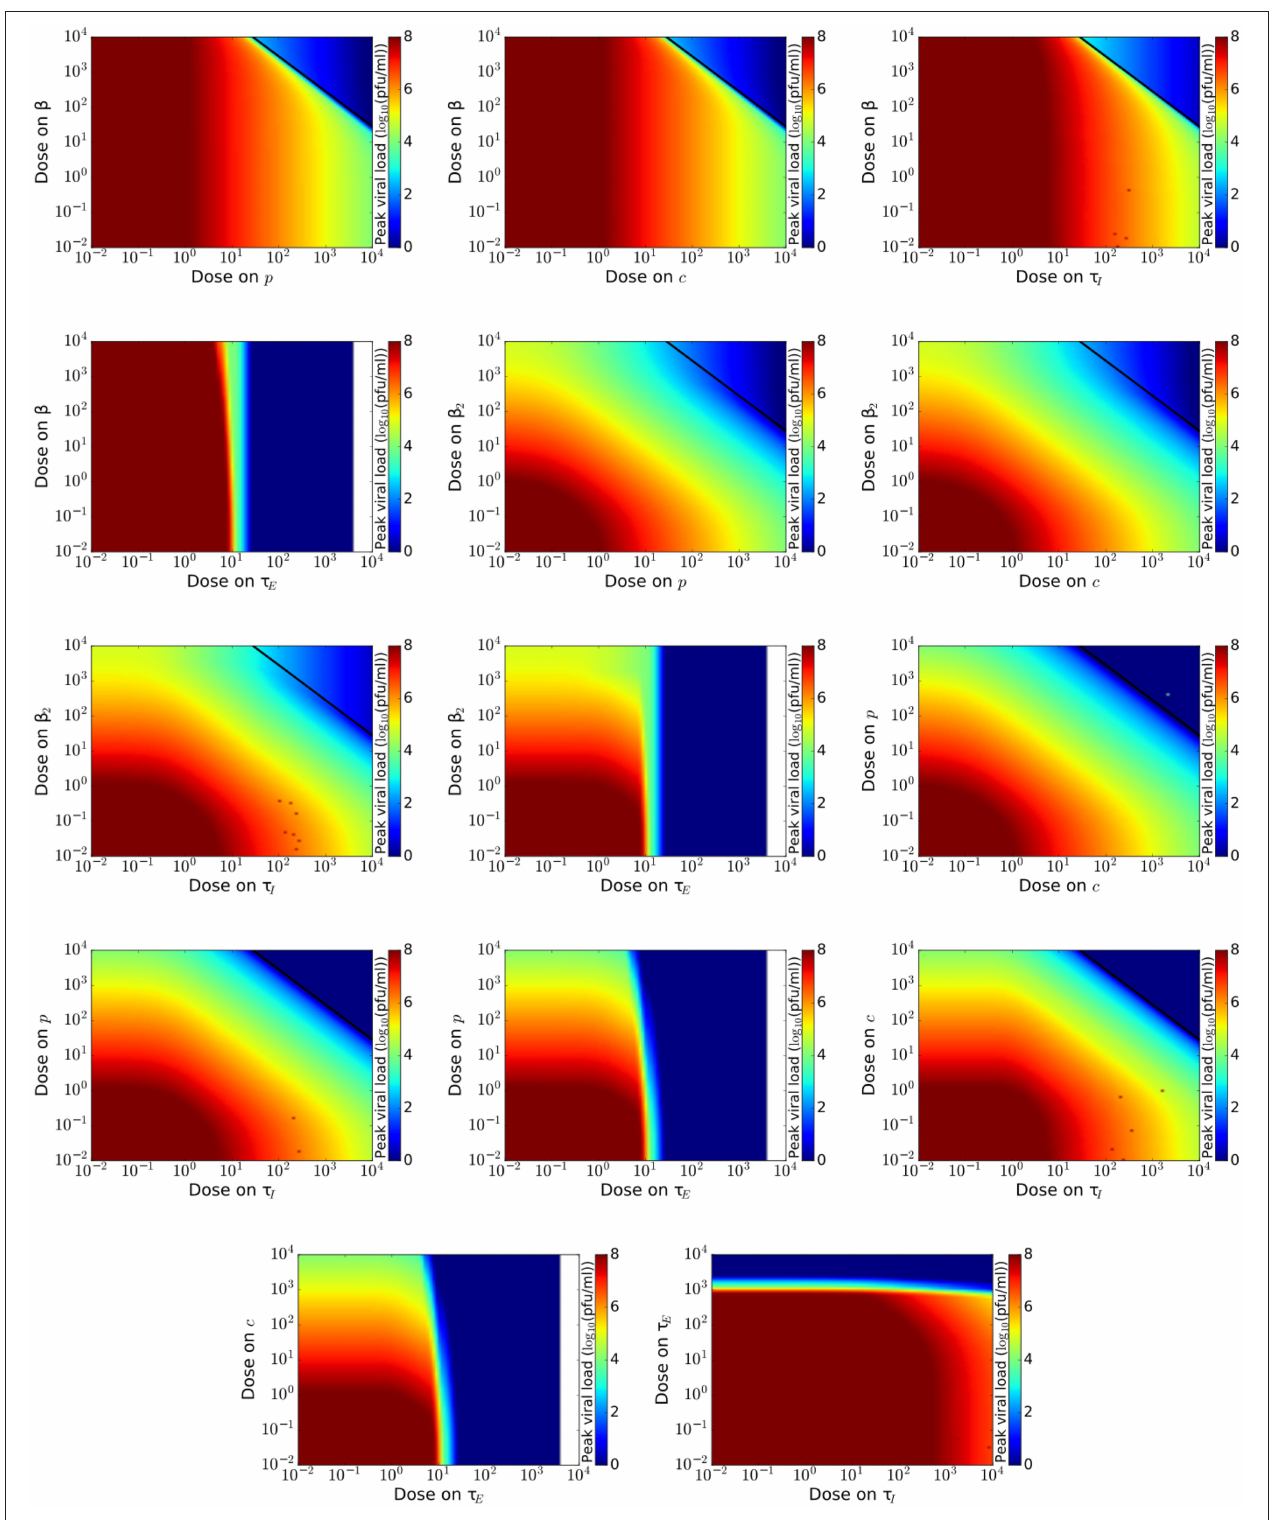
FIGURE 2 | Maximum viral titer for a range of doses of various combinations of influenza antivirals. Lowest peak viral titer is in blue with highest peak values indicated in red. The black line indicates the theoretical curve given by Equation (8) that delineates regions where the infection is cured.